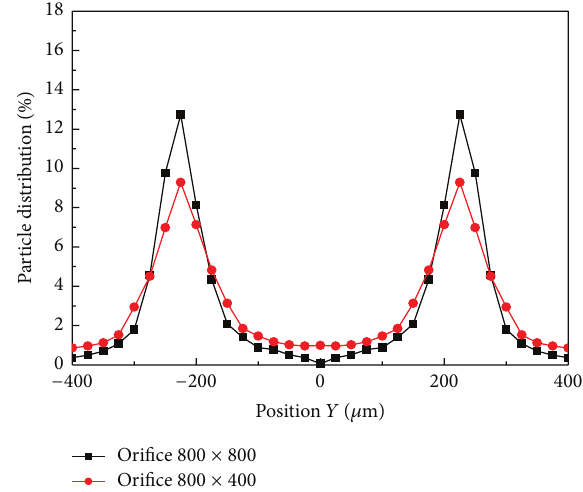
Figure 6: Trapping efficiency comparison between two kinds of